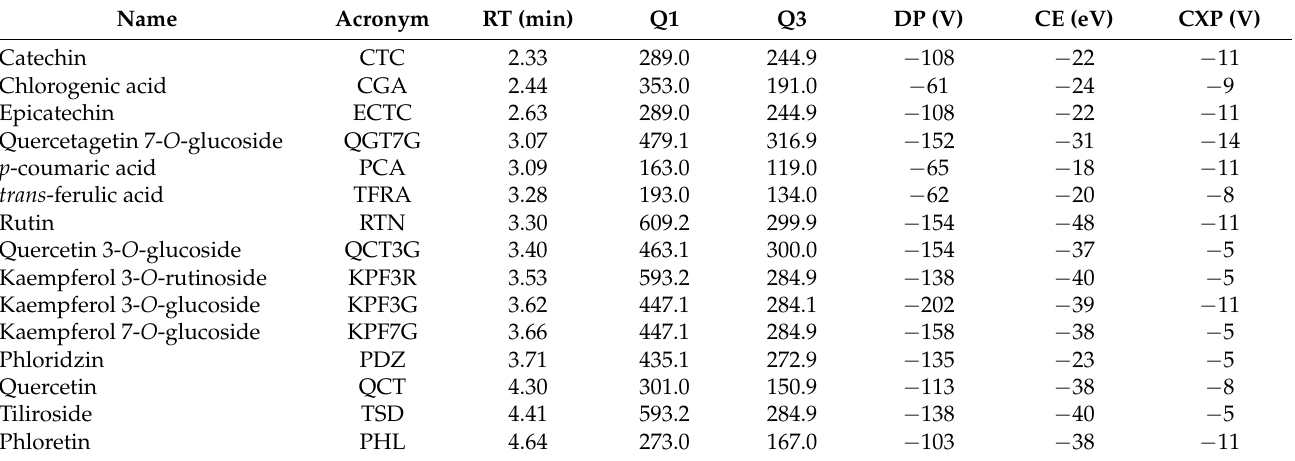
Table 1. Relative polyphenol compound parameters, retention time (RT), and selected reaction monitoring